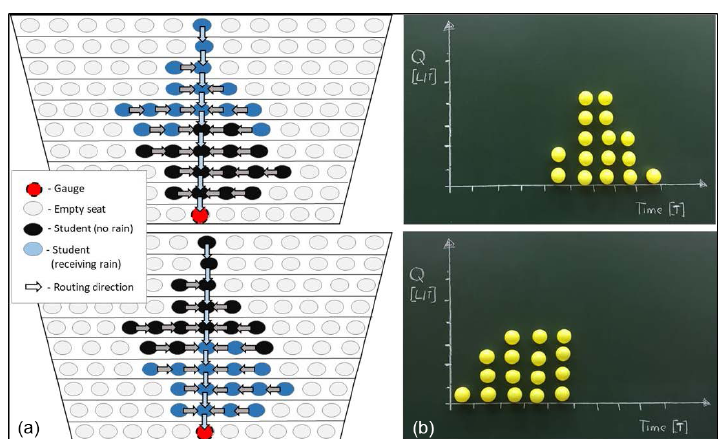
Figure 7. The effect of different spatial distributions of effective precipitation within the catchment on the resulting hydrograph. The student seating, the spatial distribution of effective precipitation, and the routing scheme are indicated in (a) , the hydrographs are illustrated in (b)